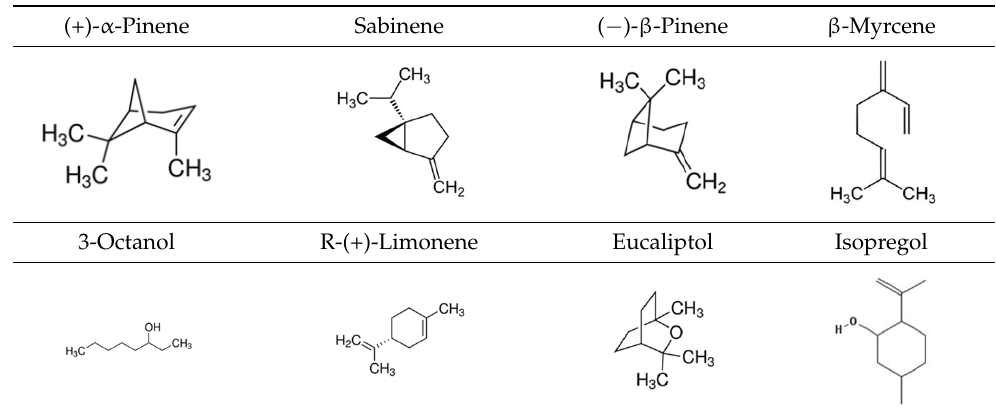
Table 1. Main components of the peppermint oil.